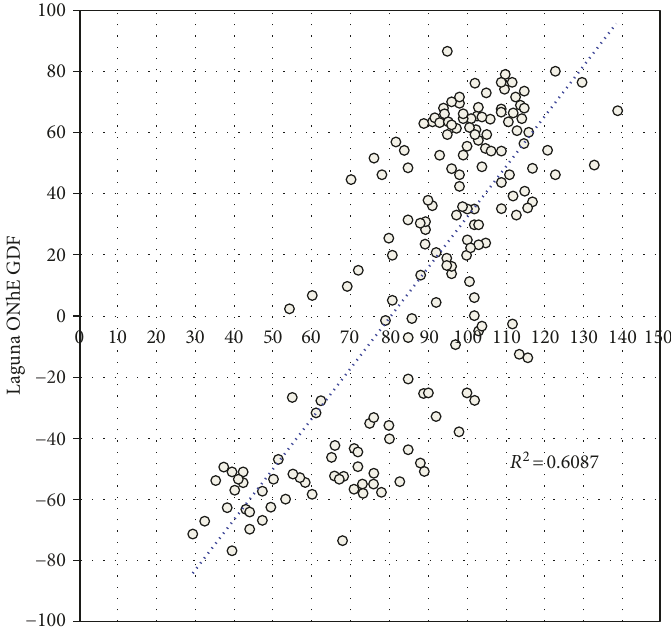
Figure 7: Scattergram of the BMO-RNFL thickness of the nerve fi ber layer measured by SPECTRALIS OCT, compared to the value of the glaucoma discriminant function (GDF) of the Laguna ONhE